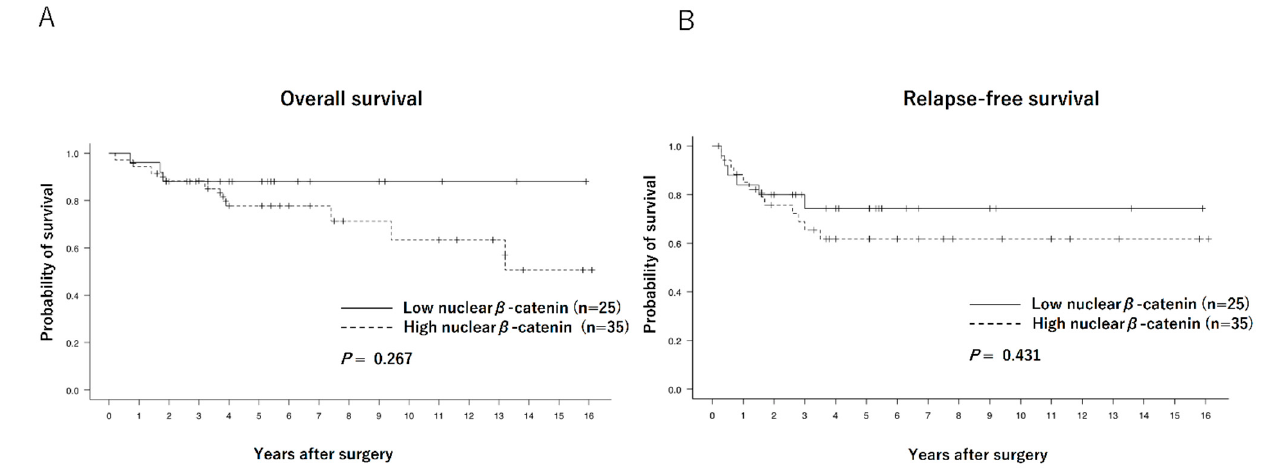
Figure 2. Overall survival curves ( A ) and relapse-free survival curves ( B ) of patients with low ( n = 25) and high ( n = 35) nuclear β -catenin expressions.